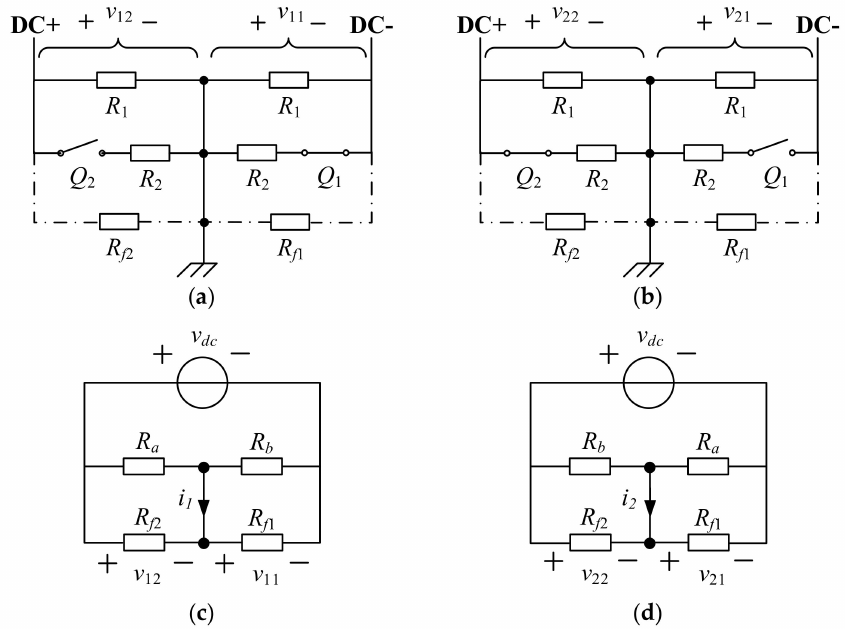
Figure 1. The circuit of unbalanced bridge. ( a ) The circuit of M 1 phase. ( b ) The circuit of M 2 phase. ( c ) The equivalent circuit of M 1 phase. ( d ) The equivalent circuit of M 2